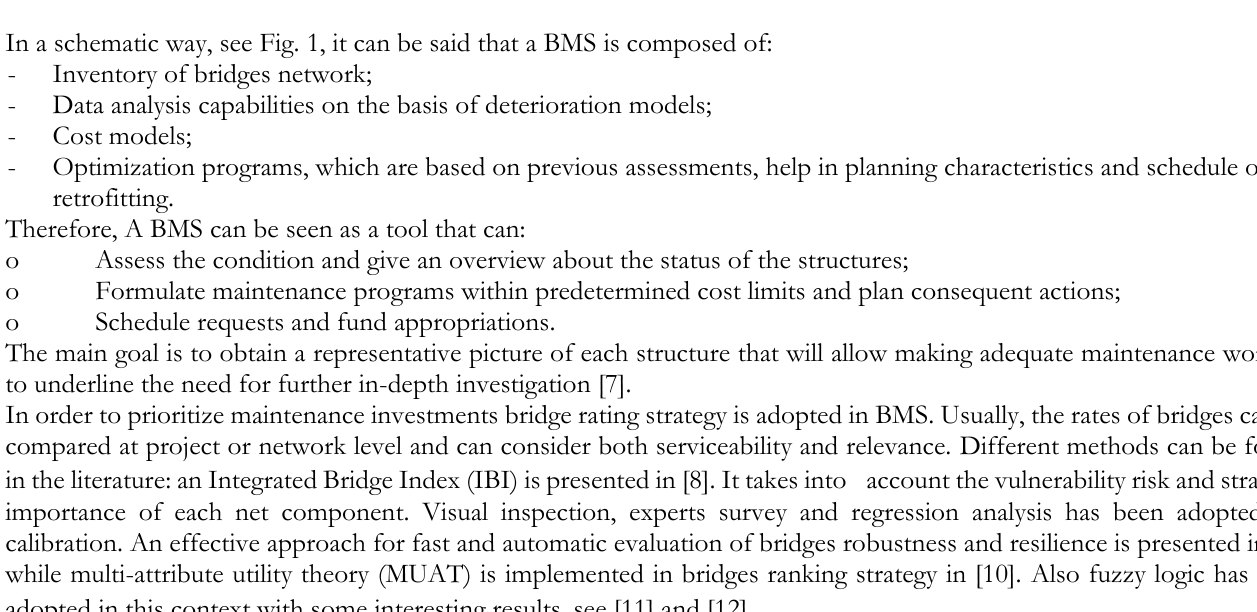
Figure 1: Bridge Management